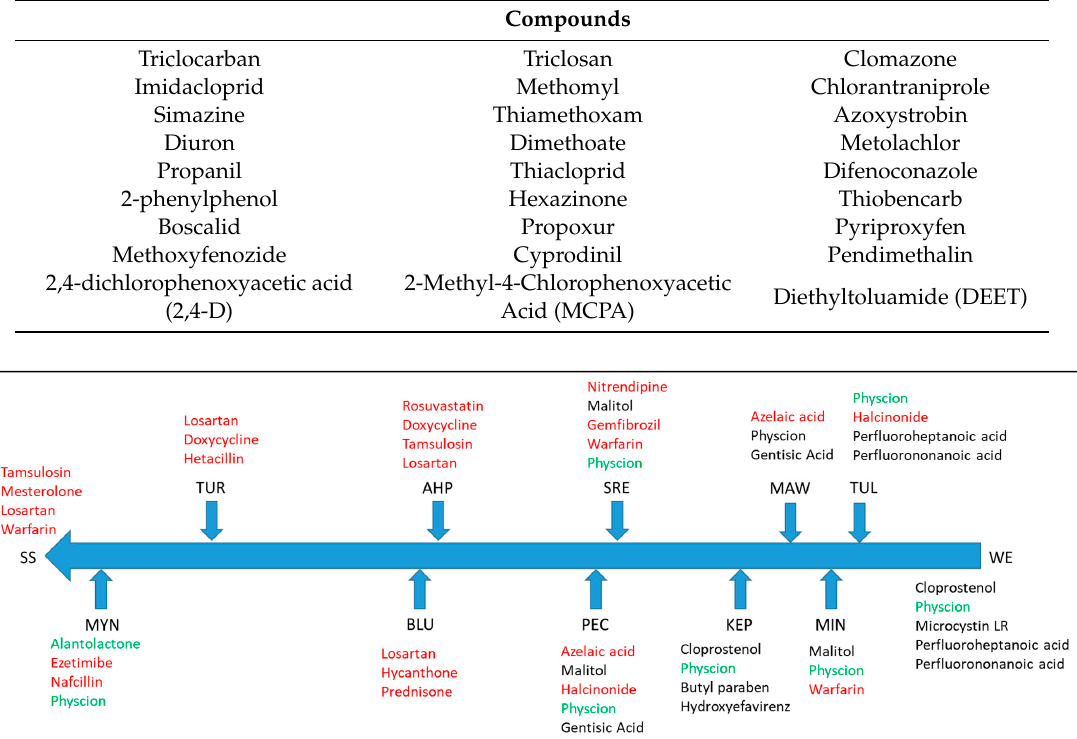
Table 4. Target Compounds Analyzed by LC-Q / TOF-MS; None were detected.